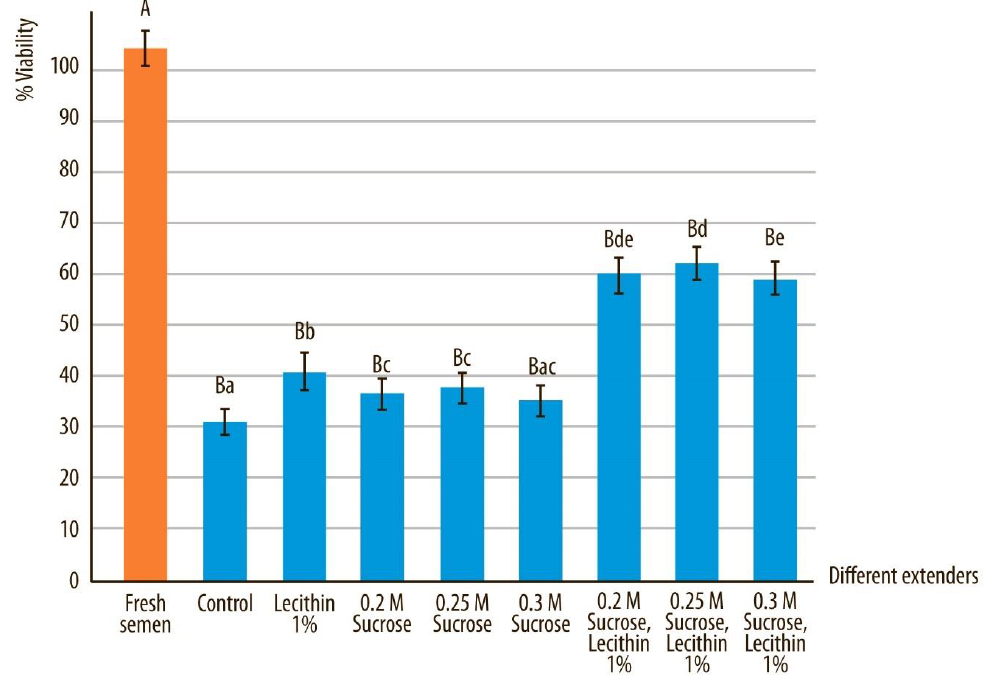
Figure 4. Viability in canine sperm after devitrification regarding different vitrification media. Data are expressed as mean ± SD.